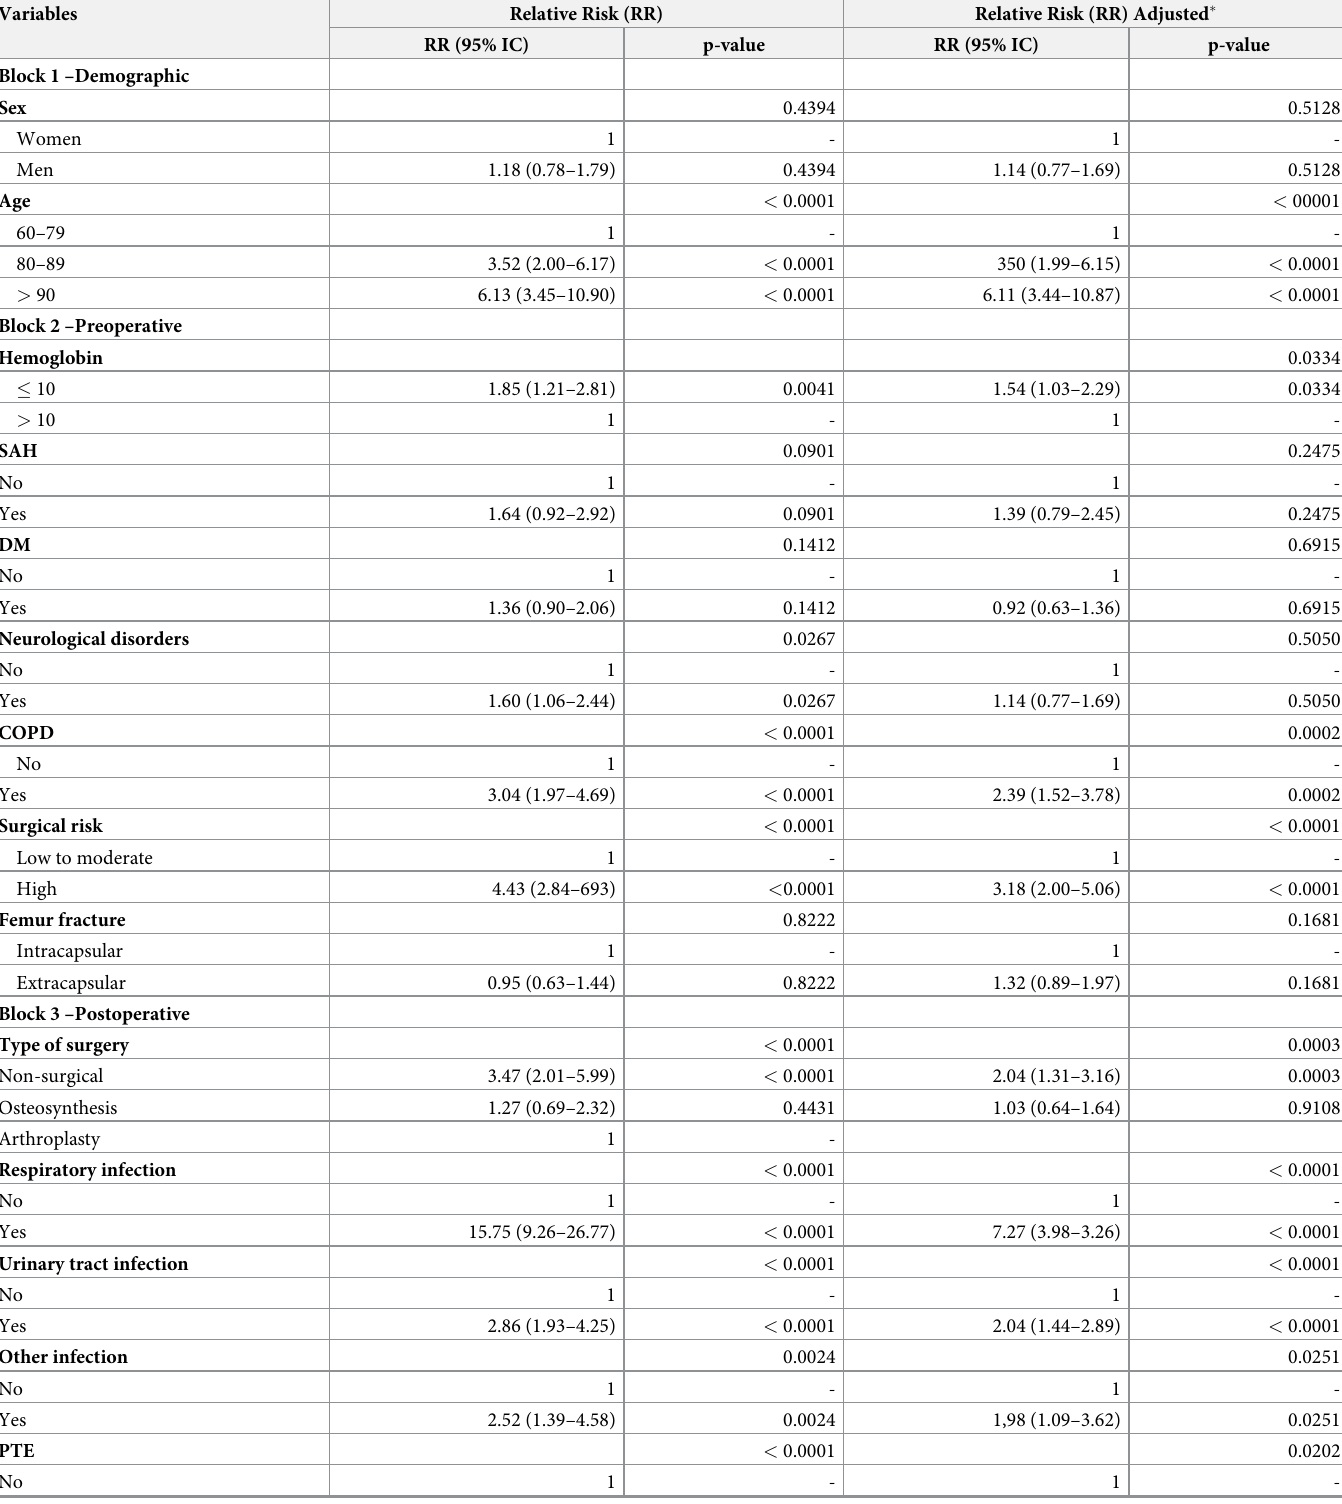
Table 3. Relative risk and prevalence ratio using the Poisson regression model with robust variance and its respective 95% confidence